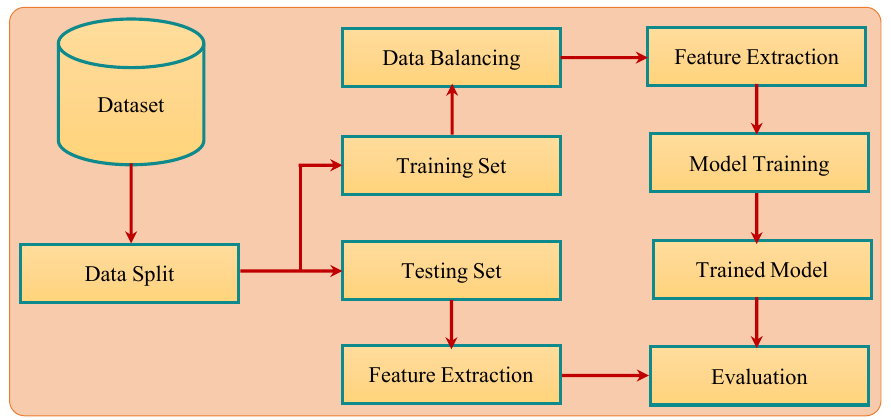
Figure 3. The pipeline of the proposed methodology for breast cancer detection.